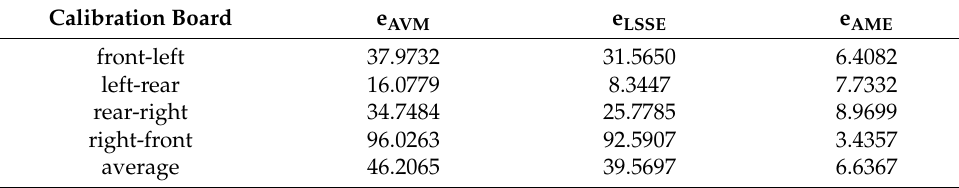
Table 4. AVM errors of the proposed method using an electric vehicle for